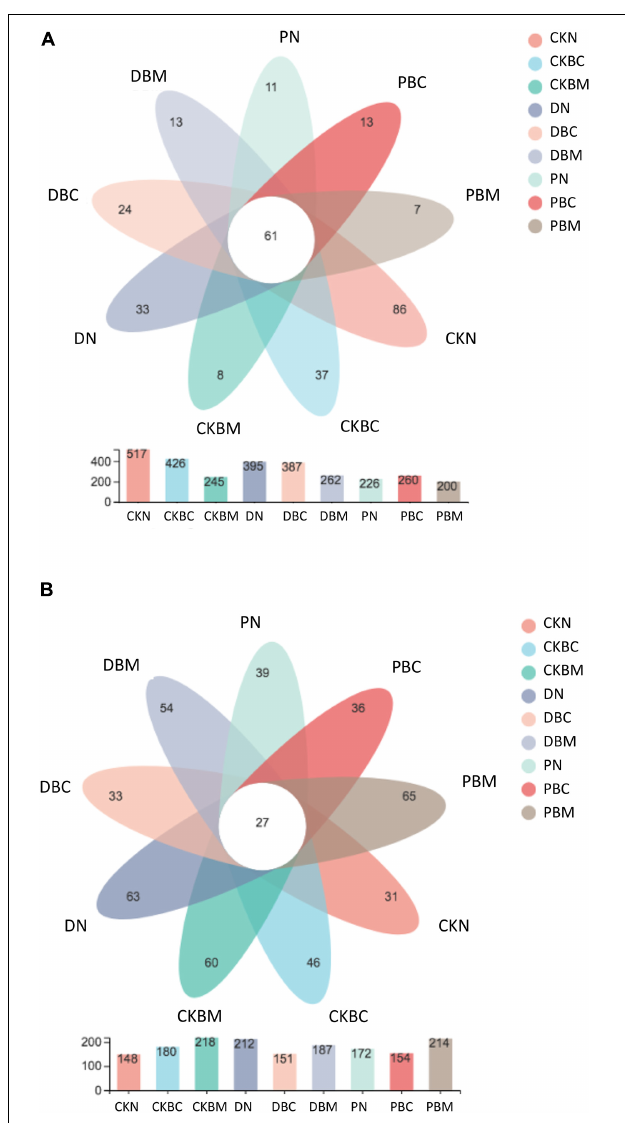
FIGURE 4 | Venn diagram of operational taxonomic unit (OTUs) of (A) bacteria and (B)